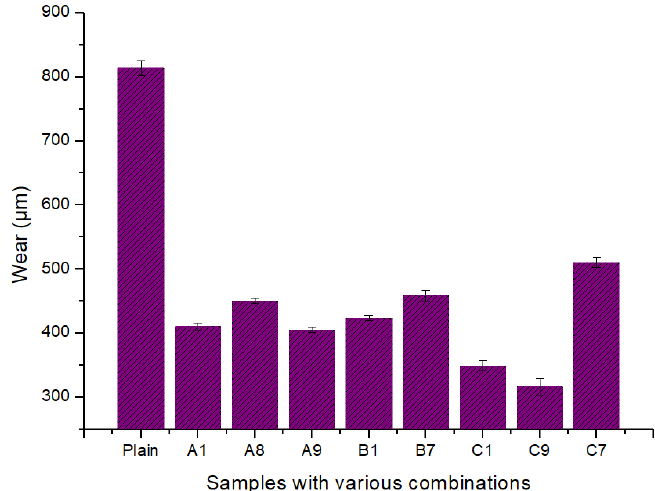
Figure 15. Wear for various pin samples, plain pins, and treated pins.